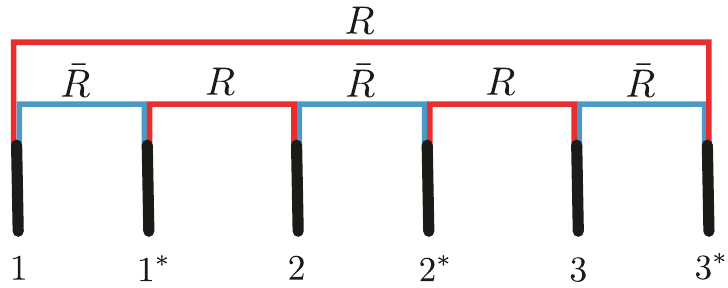
Figure 1 . Schematic representation of h R, R | for n = 3 , where the connections represent contrac- tions of subsystem indices of the corresponding